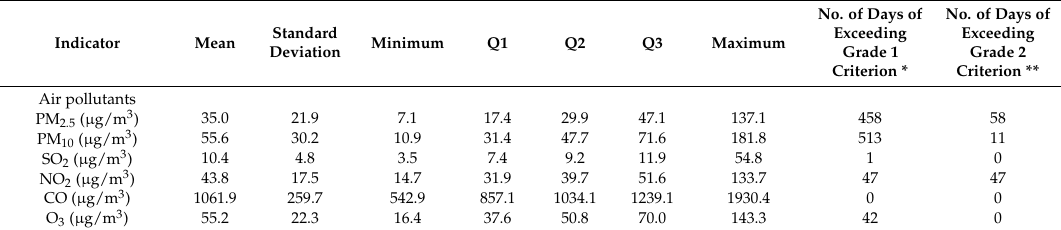
Table 2. Air pollutants and meteorological factors in Shenzhen